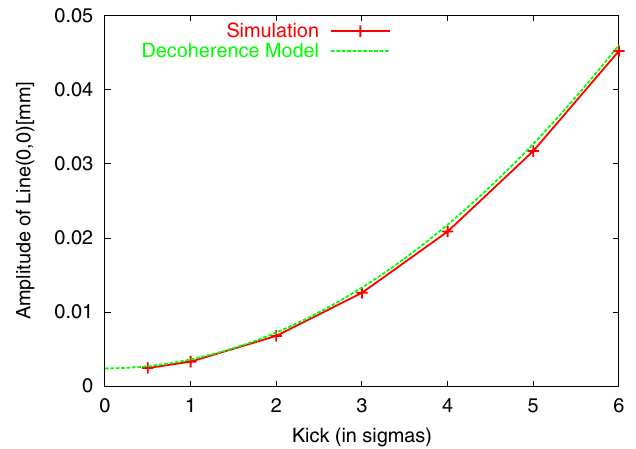
FIG. 5. (Color) Amplitude of the line (0,0) for model and simulation versus the kick A extraction sextupoles